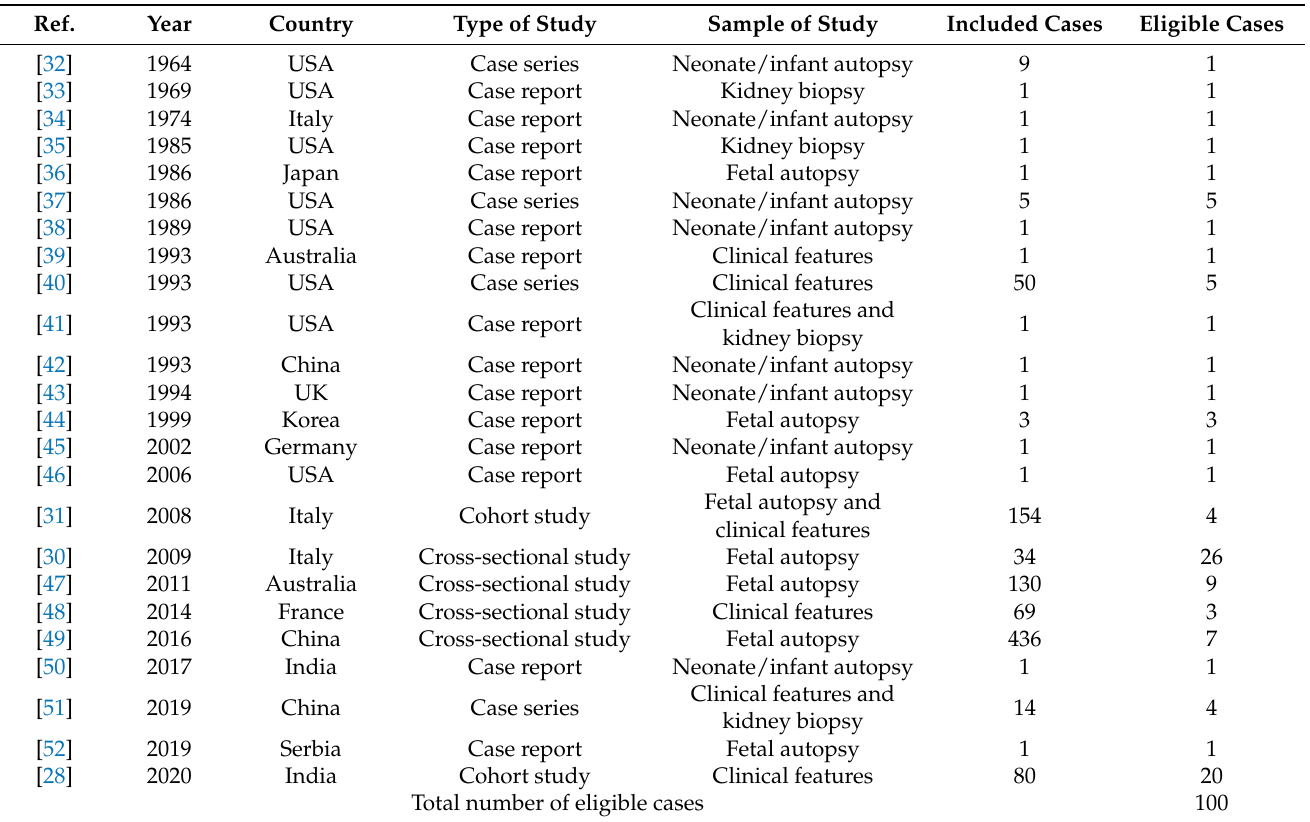
Table 1. Summaries of the articles that were included in this systematic review.